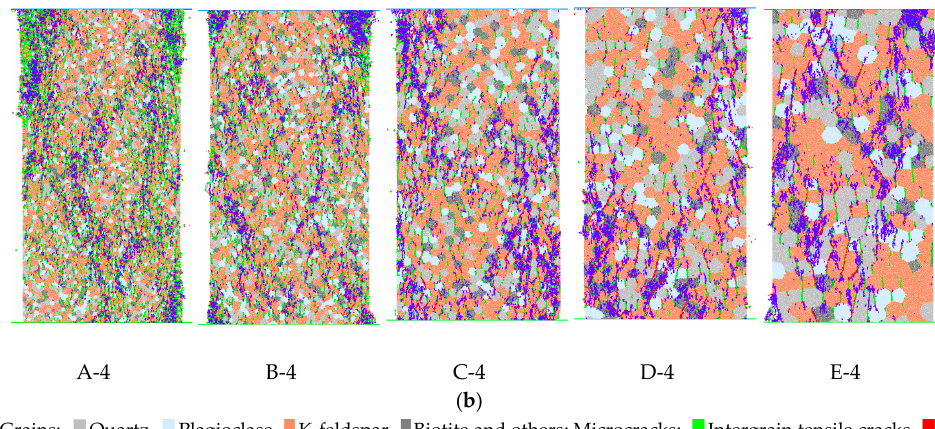
Figure 13. Mineral distributions and microcrack distributions in five representative rock models after UCS and UTS tests. ( a ) Micro-cracks distribution after UTS tests; ( b ) Micro-cracks distribution after UCS tests. Table 3. The summary of microcrack information in rock samples after UCS and UTS tests.